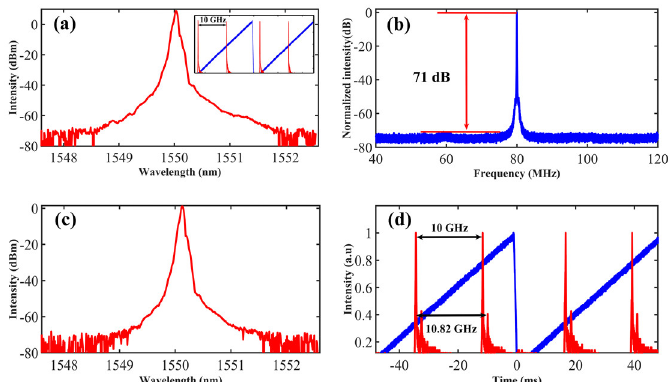
Figure 2. Spectrum of ( a ) SIL laser (Inset: FPI spectrum) and ( c ) BEFL. ( b ) Frequency domain properties of the SIL laser under maximum injected power. ( d ) FPI spectrum integrated with the BP and BEFL lasing, blue line: normalized voltage loaded to